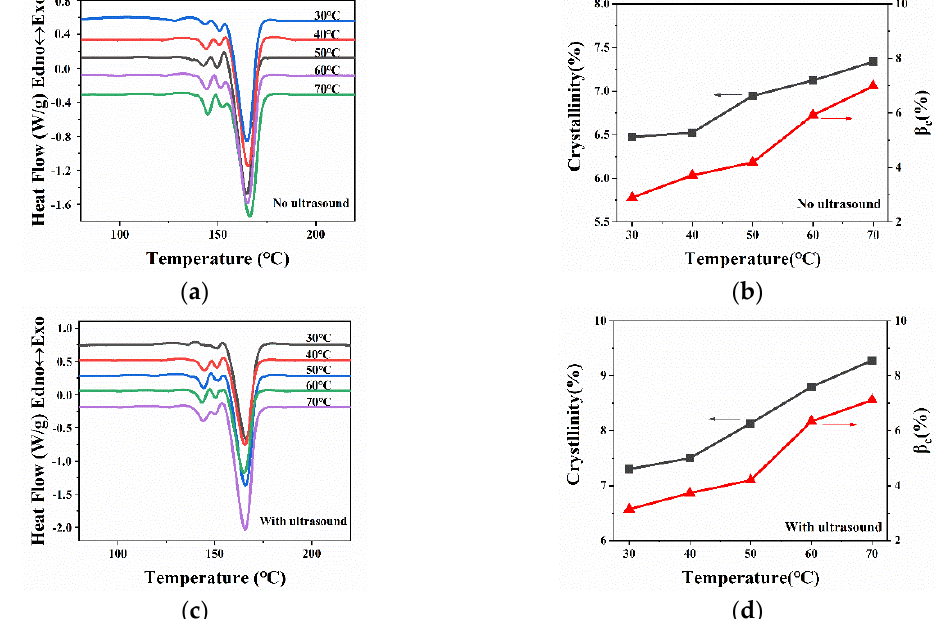
Figure 11. ( a ) The melting behaviors of WBG-PP under different cooling temperatures. ( b ) Effect of the cooling temperature on the values of β c and θ . ( c ) The melting behaviors of WBG-PP under different cooling temperatures with ultrasound. ( d ) Effect of the cooling temperature with ultrasound on the values of β c and θ . Table 3. The values of β c and θ of WBG-PP with different cooling temperatures without ultrasound and with ultrasound.